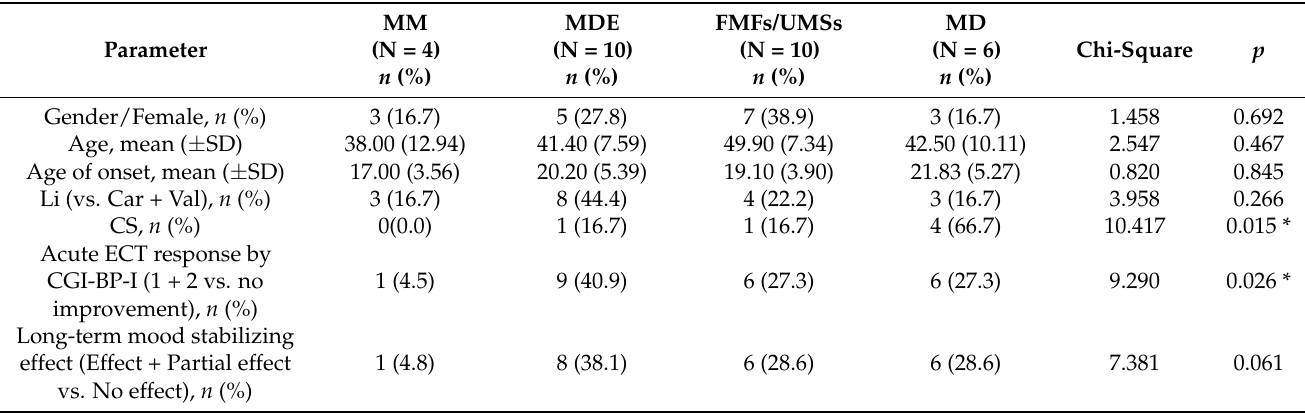
Table 3. Demographic and illness characteristics, acute ECT response, and maintenance of efficacy in different index episode groups (MM, MDE, FMFs/UMSs, and